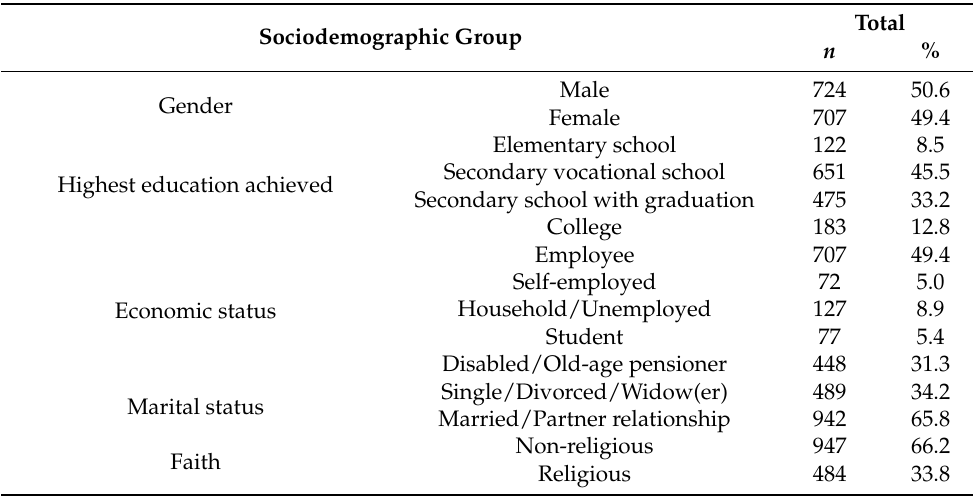
Table 1. Description of the study population.